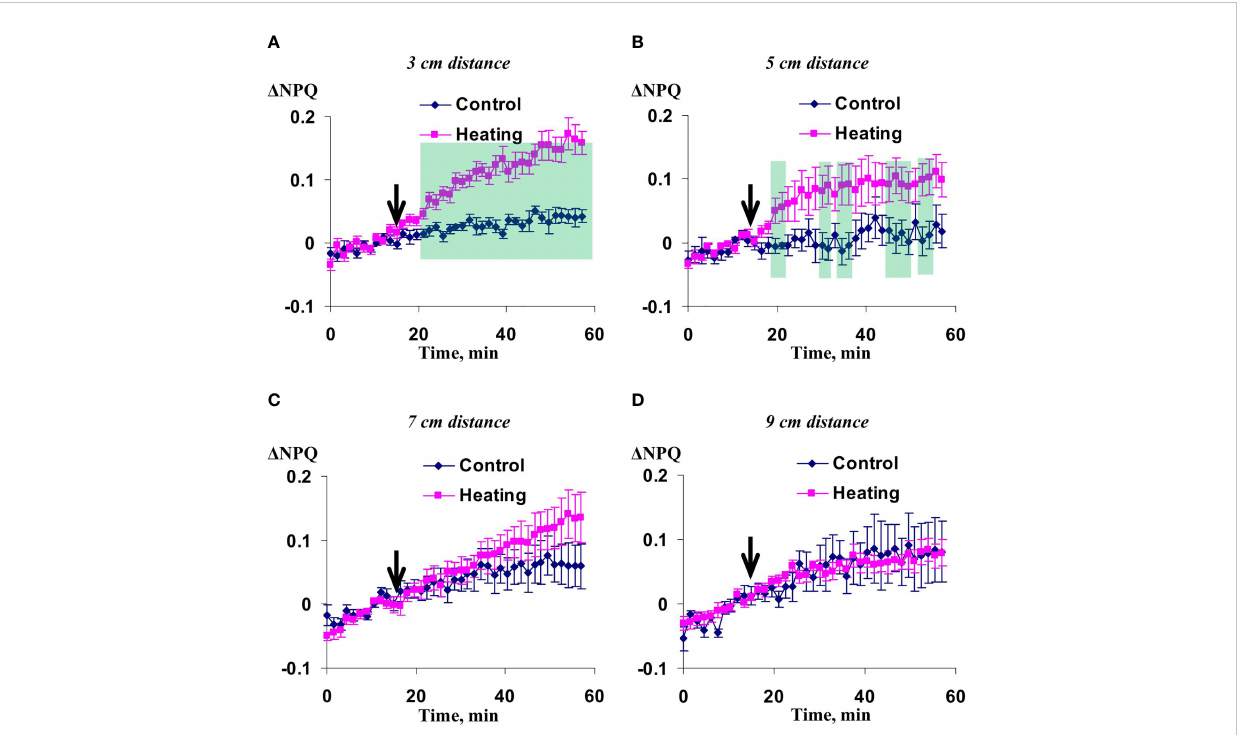
FIGURE 13 Averaged changes in the non-photochemical quenching of chlorophyll ( D NPQ) in 3 cm (A) , 5 cm (B) , 7 cm (C) , and 9 cm (D) from zone of the local action of heating in irrigated wheat plants ( n =8). Arrow marks initiation of this action; control plants were not irritated. D NPQ was calculated as NPQ - NPQ 0 , where NPQ 0 was measured before the initiation of the irritation. Intensity of the white actinic light was 456 µmol m -2 s -1 . Green shadings show time intervals with signi fi cant differences between experimental and control values ( p <0.05, Student ’ s test).